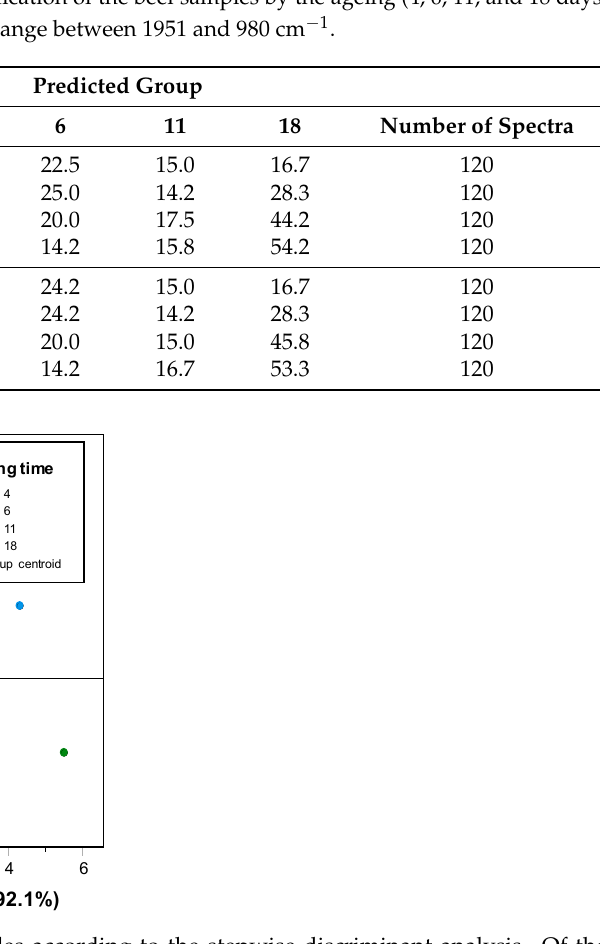
Figure 4. Classification of the samples according to the stepwise discriminant analysis. Of the 1079 wavelengths, 9 are enough to classify the samples (range 1951–980 cm − 1 ).